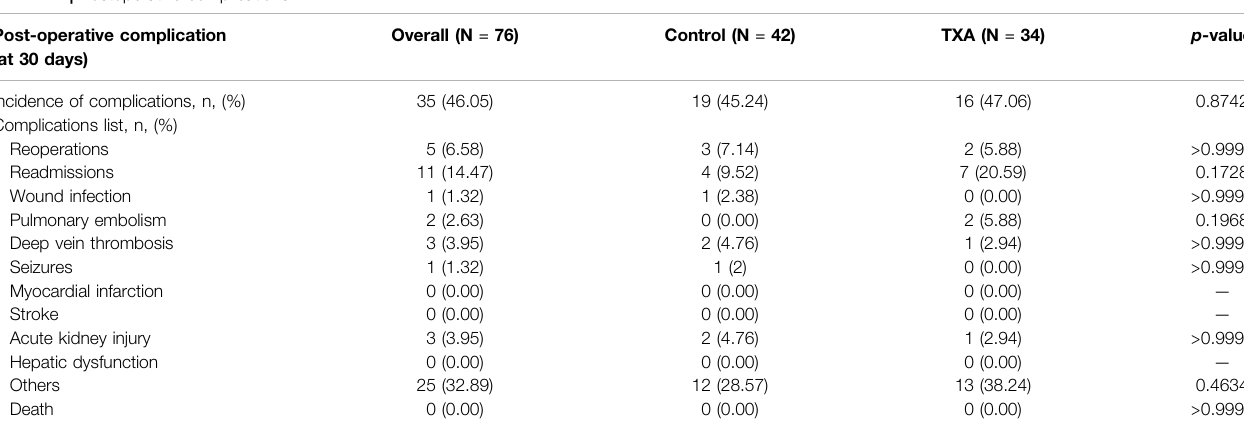
TABLE 4 | Postoperative